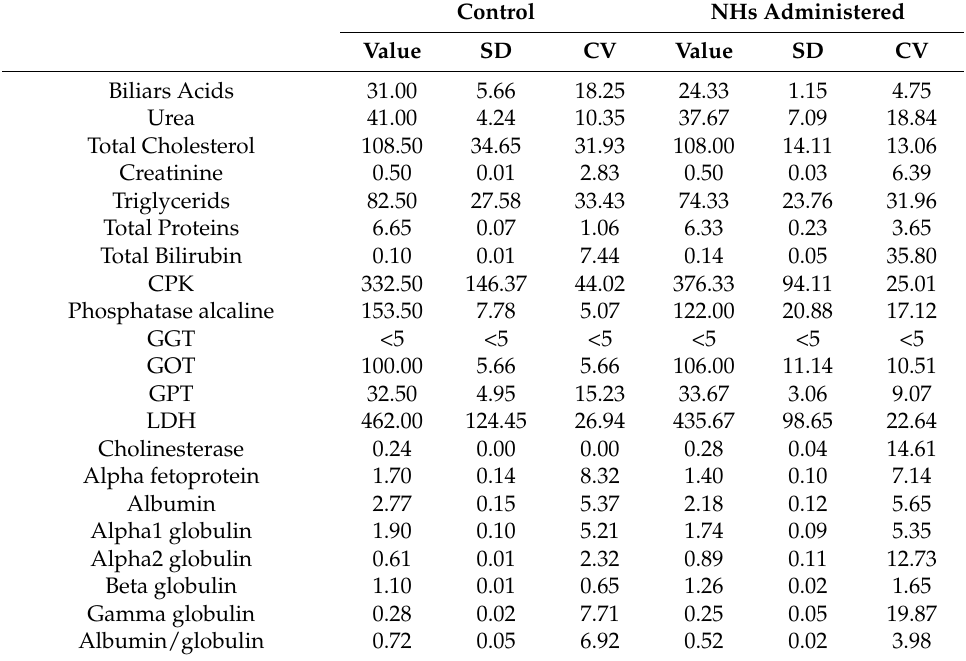
Table 3. Hepatic profile values obtained in both groups of rats in blood samples ( n = 4).